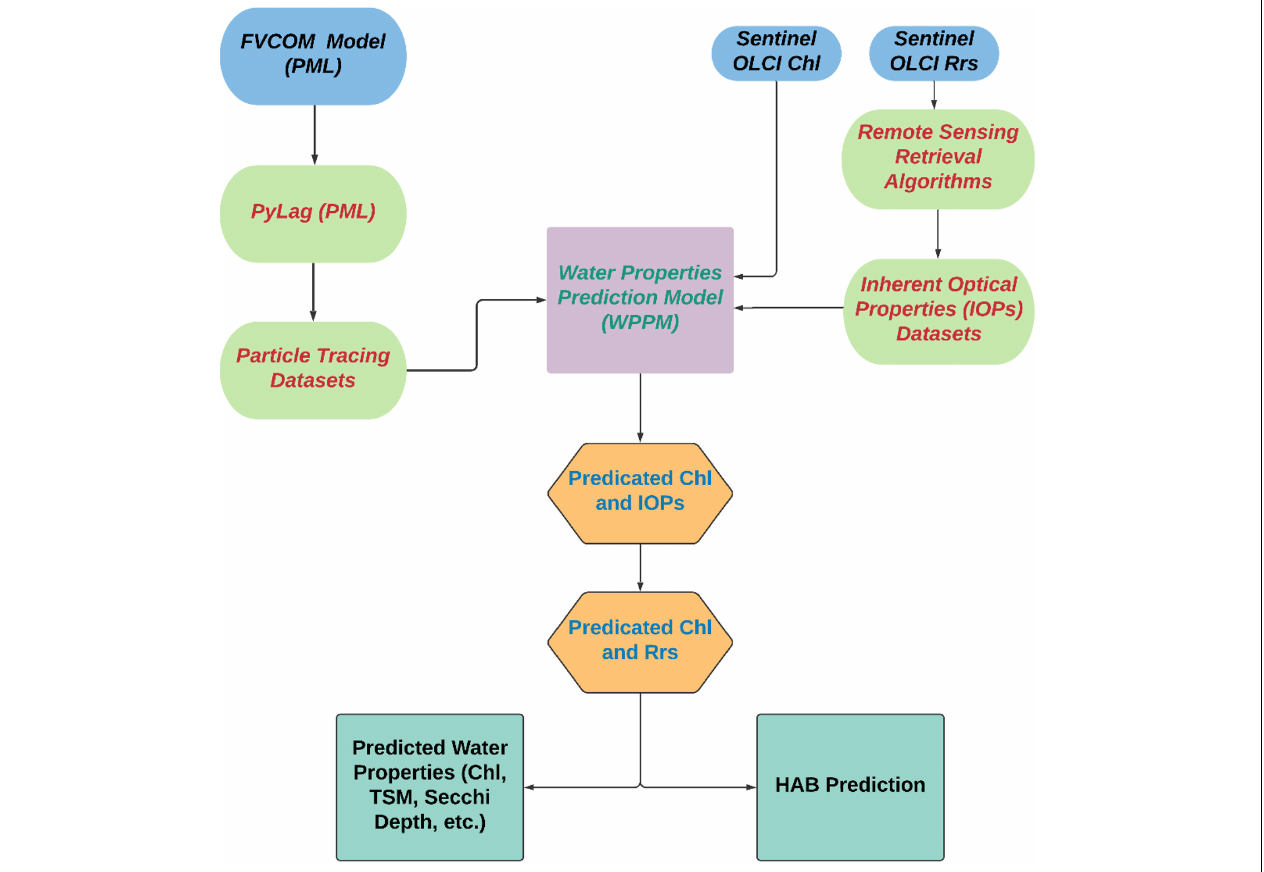
FIGURE 1 | Flowchart of ocean color prediction algorithm for water properties and early warning maps of HAB using Lagrangian particle trajectories and ocean color